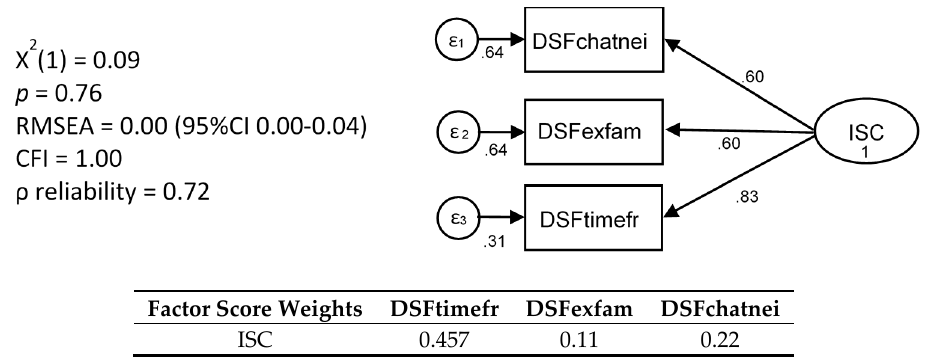
Figure A1. Final model for Informal Social Connectedness constructs of community participation.